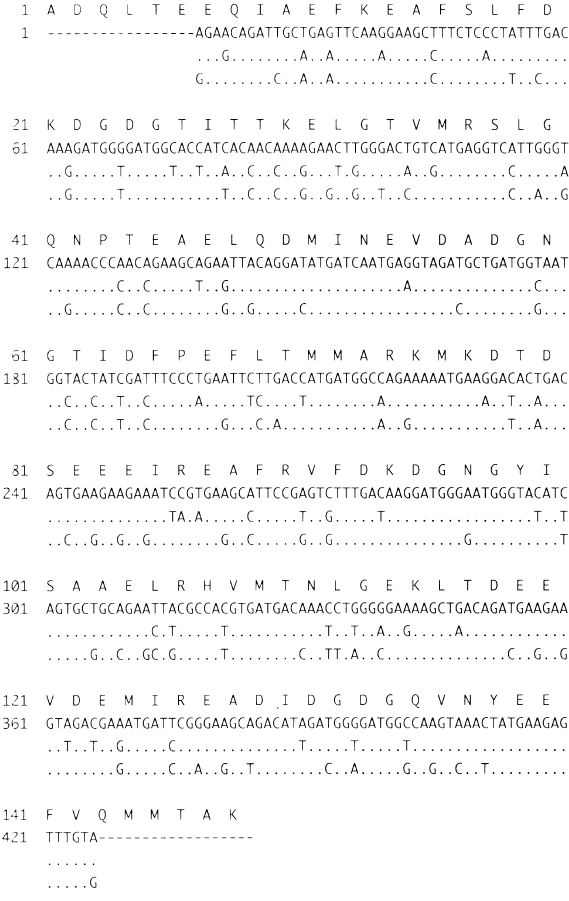
Figure1 -ThecodingsequencesoftortoiseCaMcDNAandtheirdeduced aa sequence. The deduced common aa sequence is shown in the first line, andthecodingsequencesofthecDNAofthethreetortoiseCaMs, CaM-A , -B , and -C , are shown in the second, third, and fourth line, respectively. Dashes indicate nucleotide corresponding to the primers. Dots indicate the nucleotideidenticaltothoseof CaM-A .ThesequenceofthesecDNAswill appear in the DDBJ/EMBL/GenBank under accession Nos. AB055384 ( CaM-A ), AB055385 ( CaM-B ) and AB055386 ( CaM-C